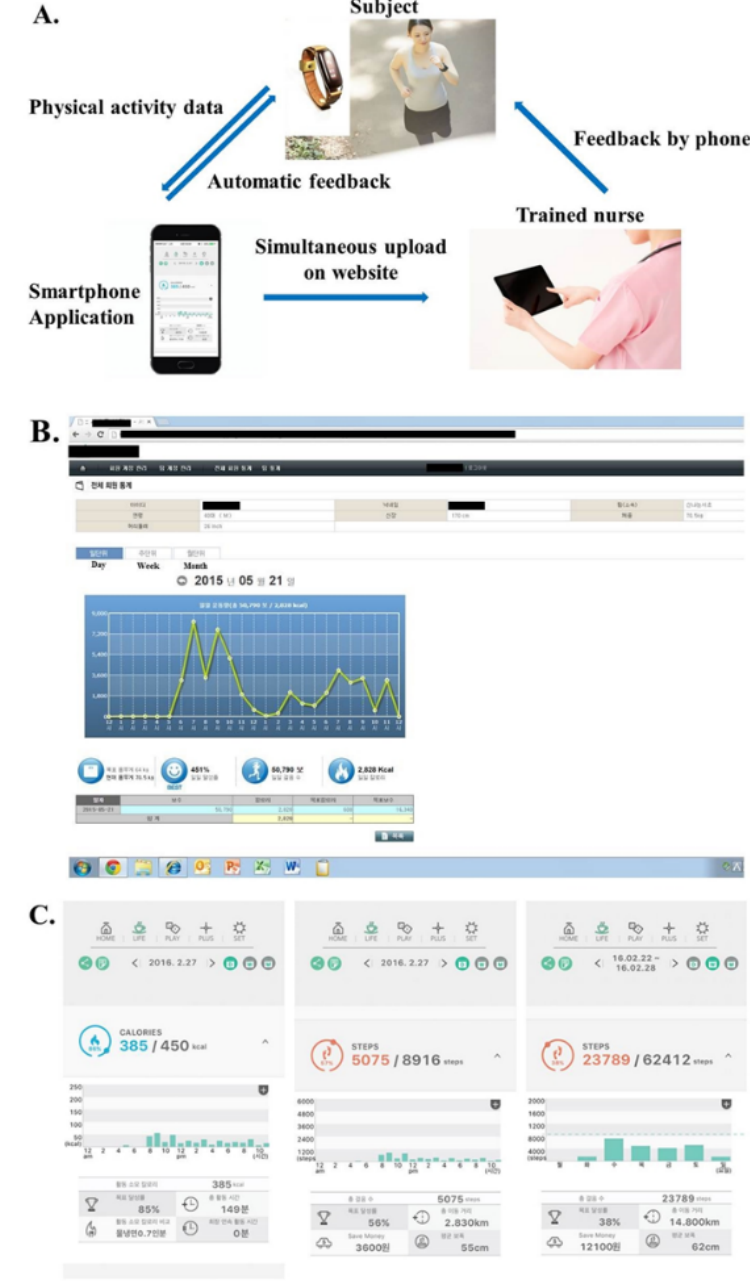
Figure 1. Overview of the intervention using the wearable device and a mobile phone app. (A) Flowchart of participants’physical activity data collection. (B) Administrative webpage allowing researchers to track the participants’physical activity. (C) App screen on the participants’mobile phones presenting the goal setting of physical activity, progress toward the daily goal, total daily steps taken, and estimation of calories burned by physical activity performed.